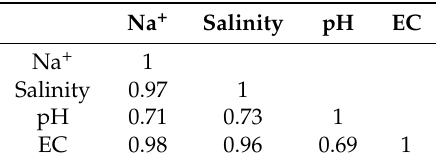
Table 4. Correlation between the main soil parameters.